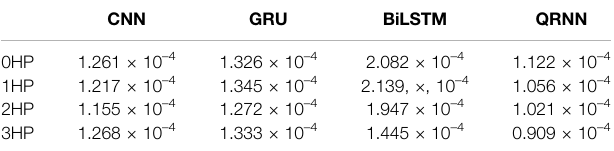
TABLE 2 | Mean square error of trend prediction of QRNN, CNN, GRU, and BiLSTM methods on data sets under different